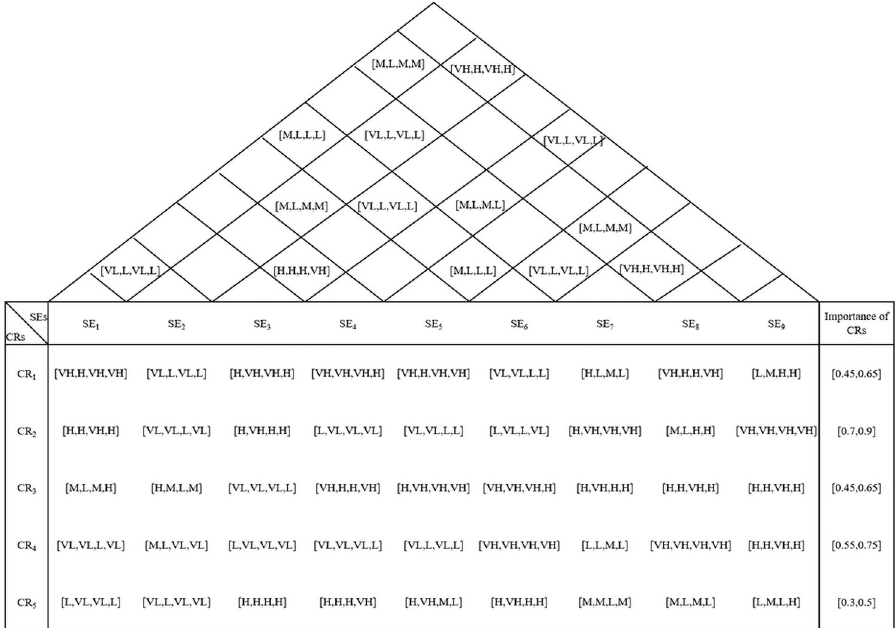
Fig 3. Basic HOQ for the medical supplier selection problem.